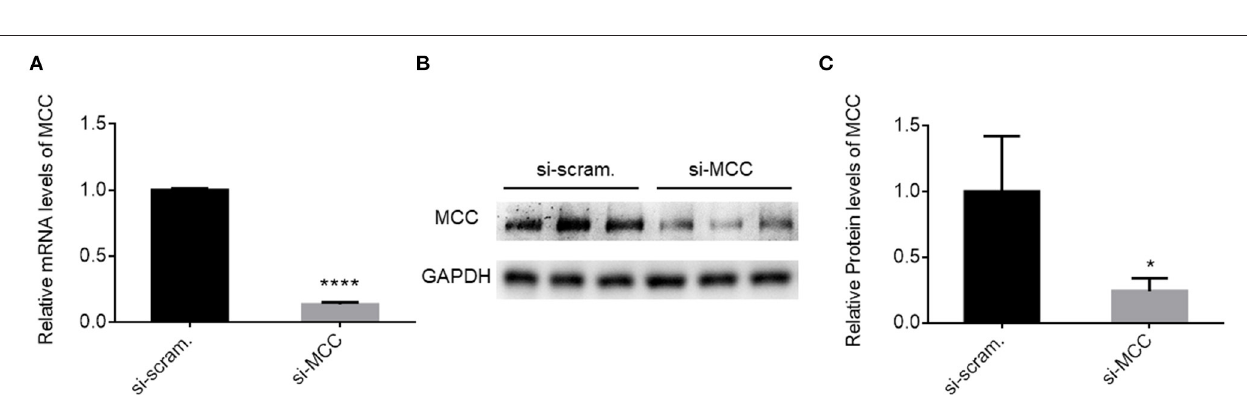
FIGURE 2 | Subcellular localization of MCC protein in podocytes in culture. (A) Fluorescence immunostaining of MCC and DAPI in cultured podocytes treated with scramble and si-MCC, respectively, which shows MCC protein in the cytoplasm, nucleus and periphery of the cells. (B) Representative immunoblotting of MCC in the cytoplasmic and nuclear fractions of human glomerular cells. GAPDH served the cytoplasmic marker, while Lamin B1 the nuclear marker. MCC expression in tubules was also examined, showing cytoplasmic and nuclear distribution; however, the protein levels were both significantly lower than that in glomerular cell cytoplasm and nuclei, respectively.